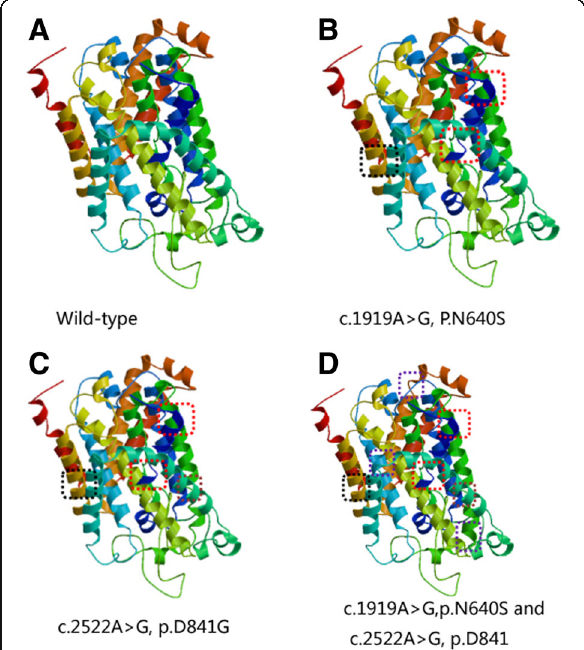
Fig. 5 Effect of SLC12A3 mutations on the modeled structure of the Na-Cl cotransporter (NCC) protein. Compared to the wild-type ( a ), c.1919A> G ( b ) alone caused three visible differences in the protein structure (marked with red and black frames), whereas c.2522A> G ( c ) alone led to one further difference (marked with a brown frame). Coexistence of c.1919A > G and c.2522A > G ( d ) resulted in three more differences (marked with purple